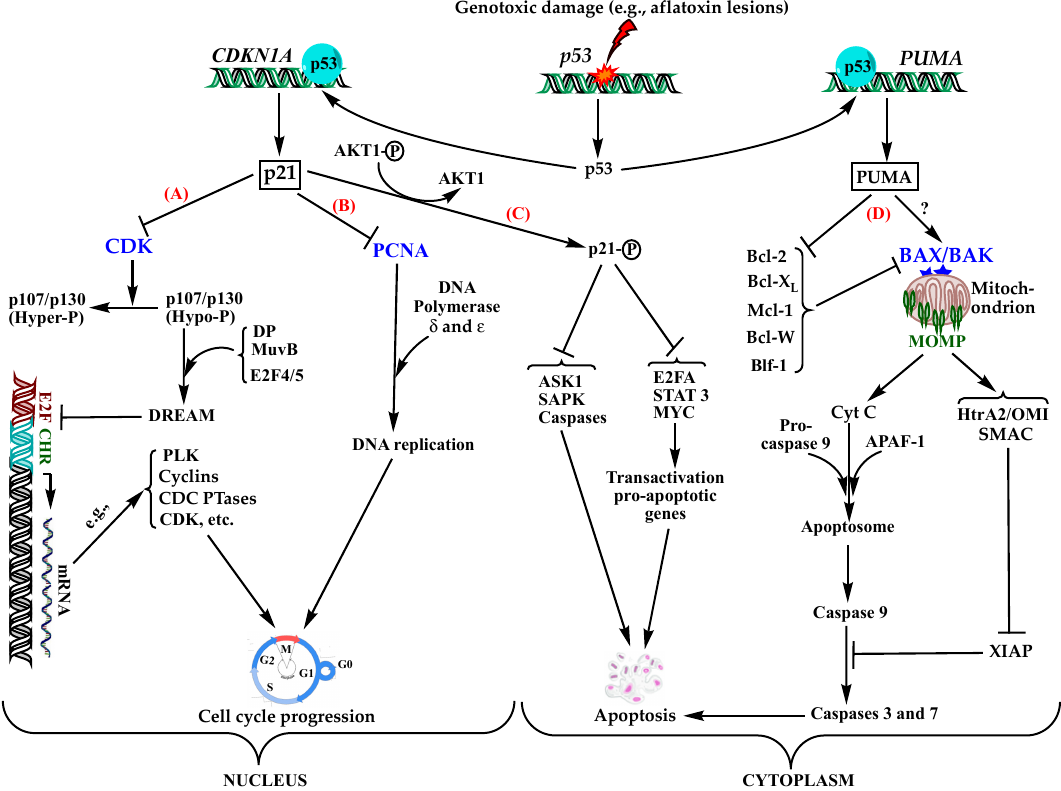
Figure 3. Main mechanisms used in normally functioning cells to induce cell cycle arrest or apoptosis as a response to DNA damage a ff ecting p53 gene to inhibit cell cycle progression in the nucleus ( A , B ), or apoptosis in the cytoplasm ( C , D ). ( A ) p21, as a potent inhibitor of CDKs, inhibits the phosphorylation of p107 and p130 proteins, which in their hypo-phosphorylated states can bind to MuvB core complex, E2F4-5, and DP and form an active DREAM complex. Once formed, DREAM binds to E2F and CHR promoters and represses the transcription of many genes, e.g., polo-like kinases (PLK1), cyclins A, B1, and B2, CDK1, CDCs 20, 25A, and 25C, MCM5, BIRC5, etc., involved in the progress of the cell cycle at di ff erent stages and checkpoints, thereby arresting the cell cycle at any stage of the progression depending on the gene(s) inhibited [55]. In the absence of p21, CDKs remain active and hyper-phosphorylate p107 and p130 preventing them from binding to the other DREAM components, thereby leaving E2F and CHR promoter sites free to bind transcriptional activators that, on the